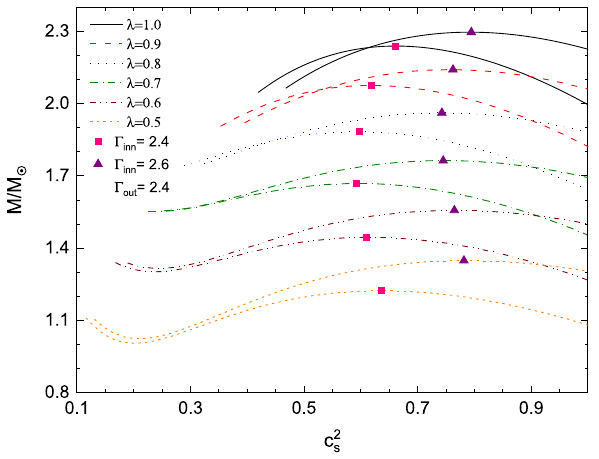
Fig. 4 Total mass against the speed of sound for four values of λ , ρ dis = 8 × 10 17 [ kg / m 3 ] , Γ = 2 . 4, and two different values of Γ out inn